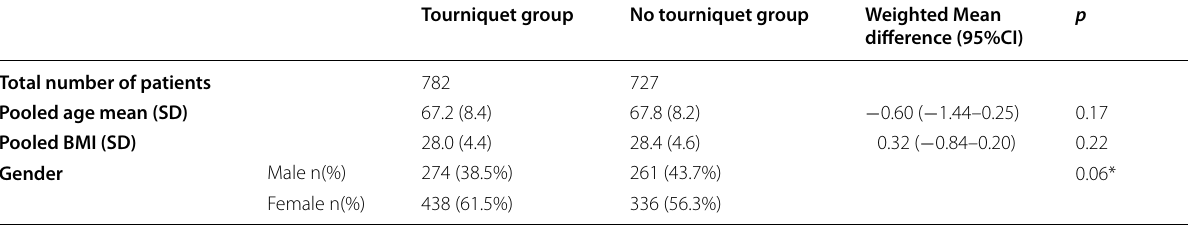
Table 2 Comparison of baseline characteristics for the two